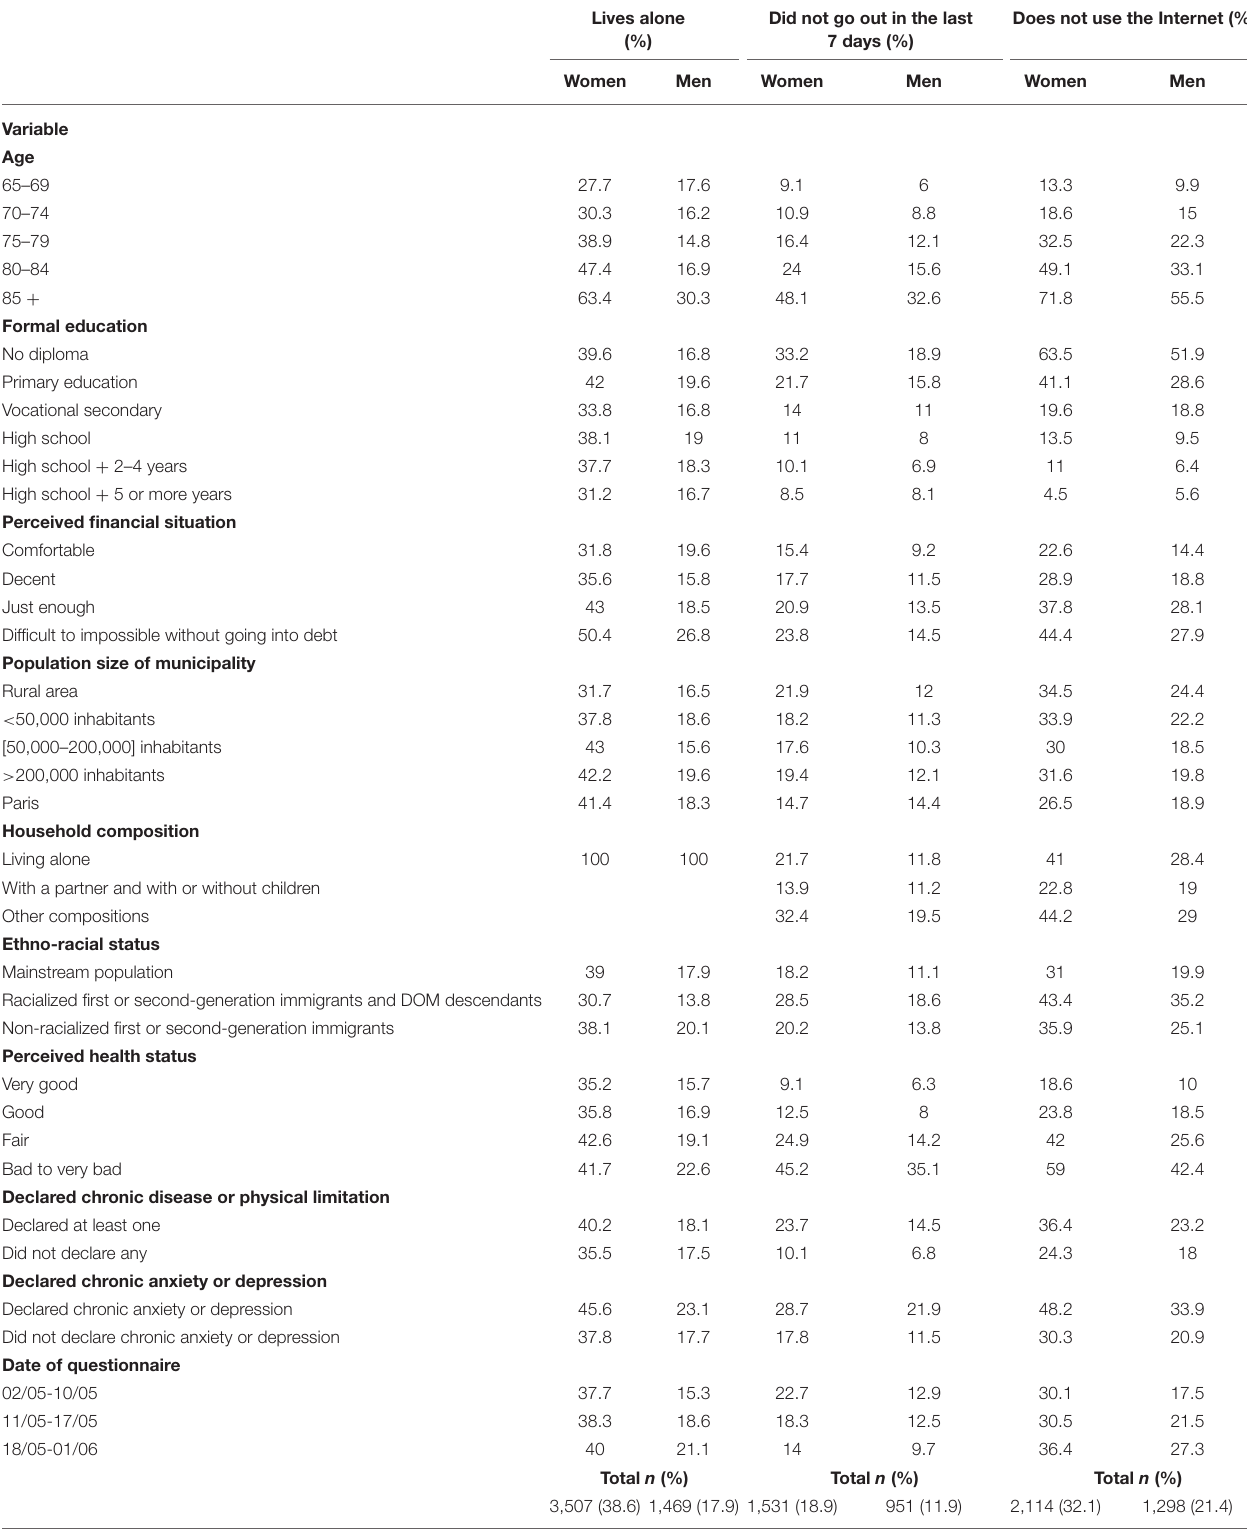
TABLE 1 | Characteristics of isolation indicators by gender.